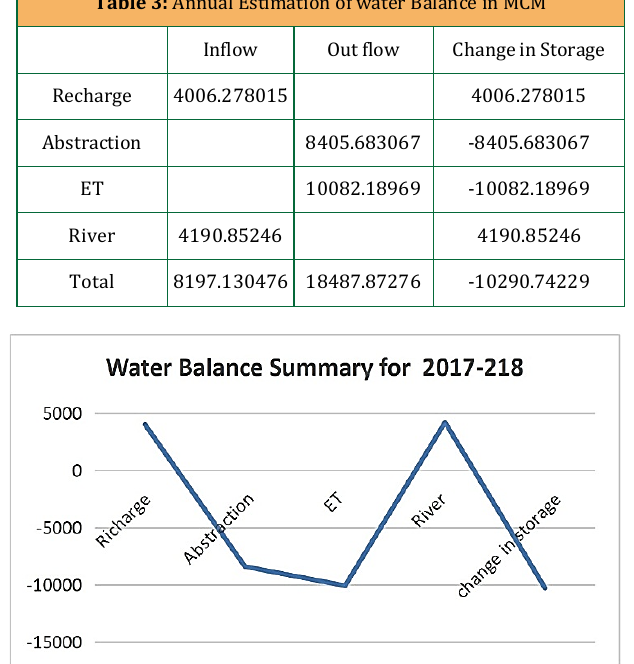
Figure 3: Water Balance summary of Command Area (MCM)